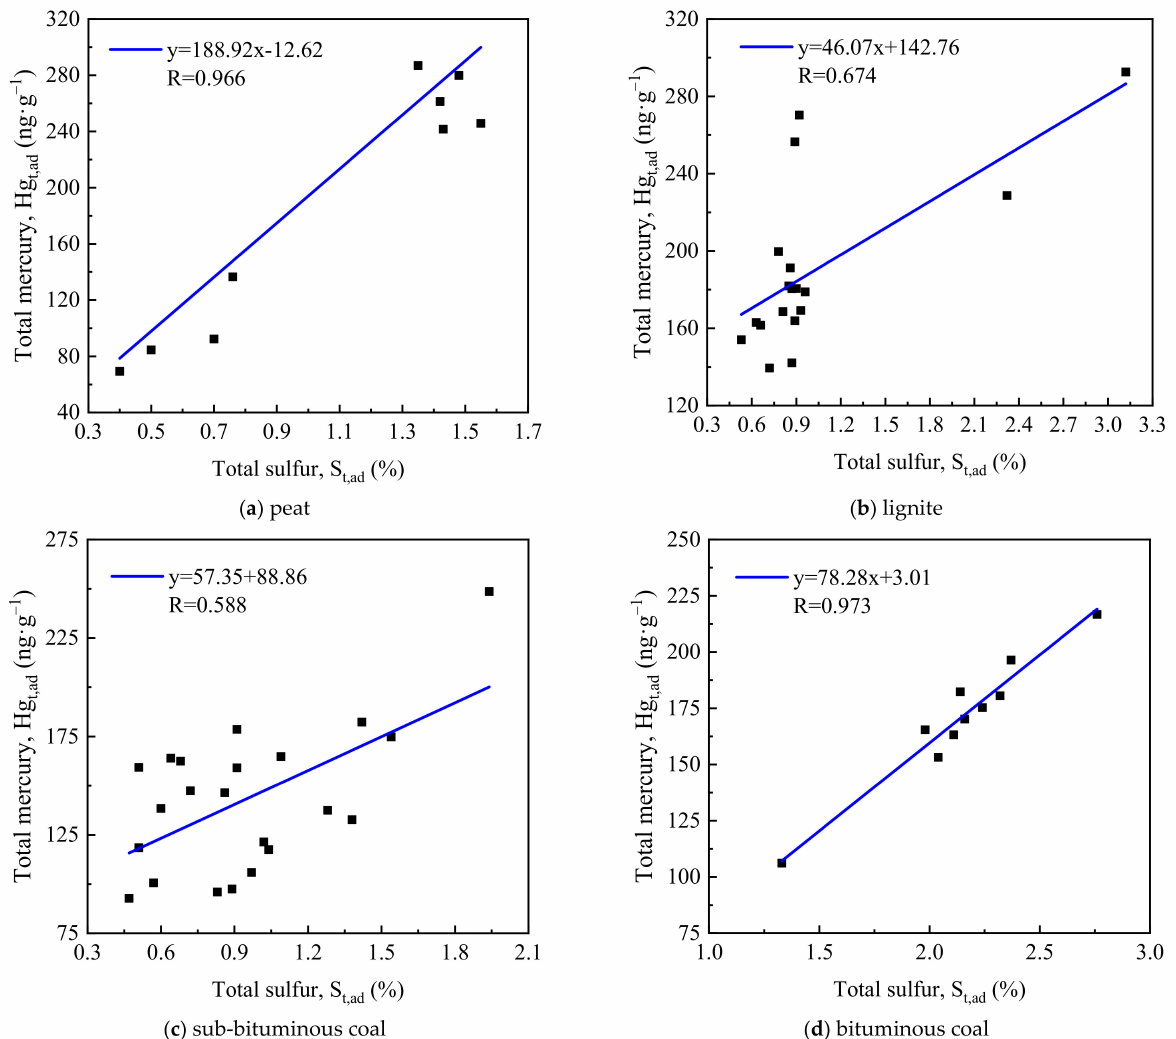
Figure 4. Correlation between Hg and total sulfur for coal samples with different ranks.